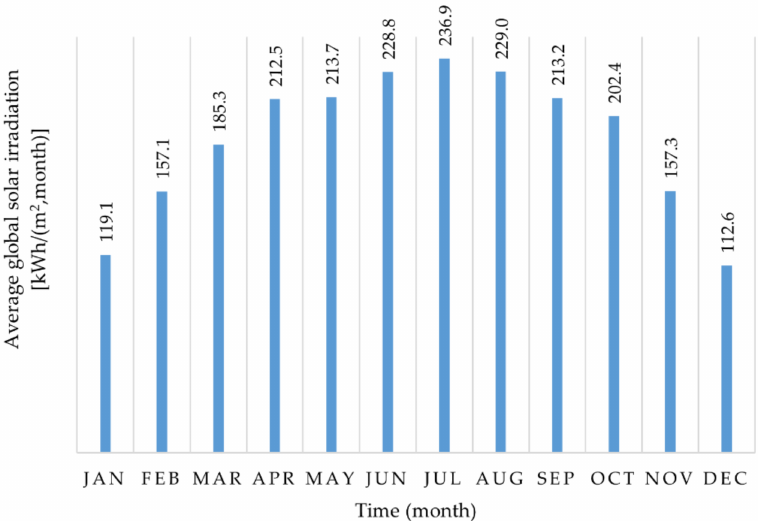
Figure 4. Average monthly global solar irradiation for the selected location with 31 ◦ 57 (cid:48) 47.3688” N and 35 ◦ 55 (cid:48) 49.2924” E latitude and longitude, respectively, obtained from PVGIS. Abbreviations: Photovoltaic Geographical Information System